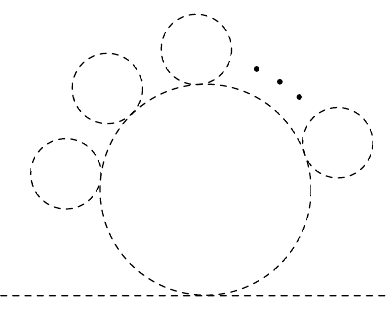
Figure 1 . Daisy contributions to the two-point function from the quartic interaction. Each additional loop contributes a factor λT 2 /m 2 , spoiling perturbativity unless appropriately